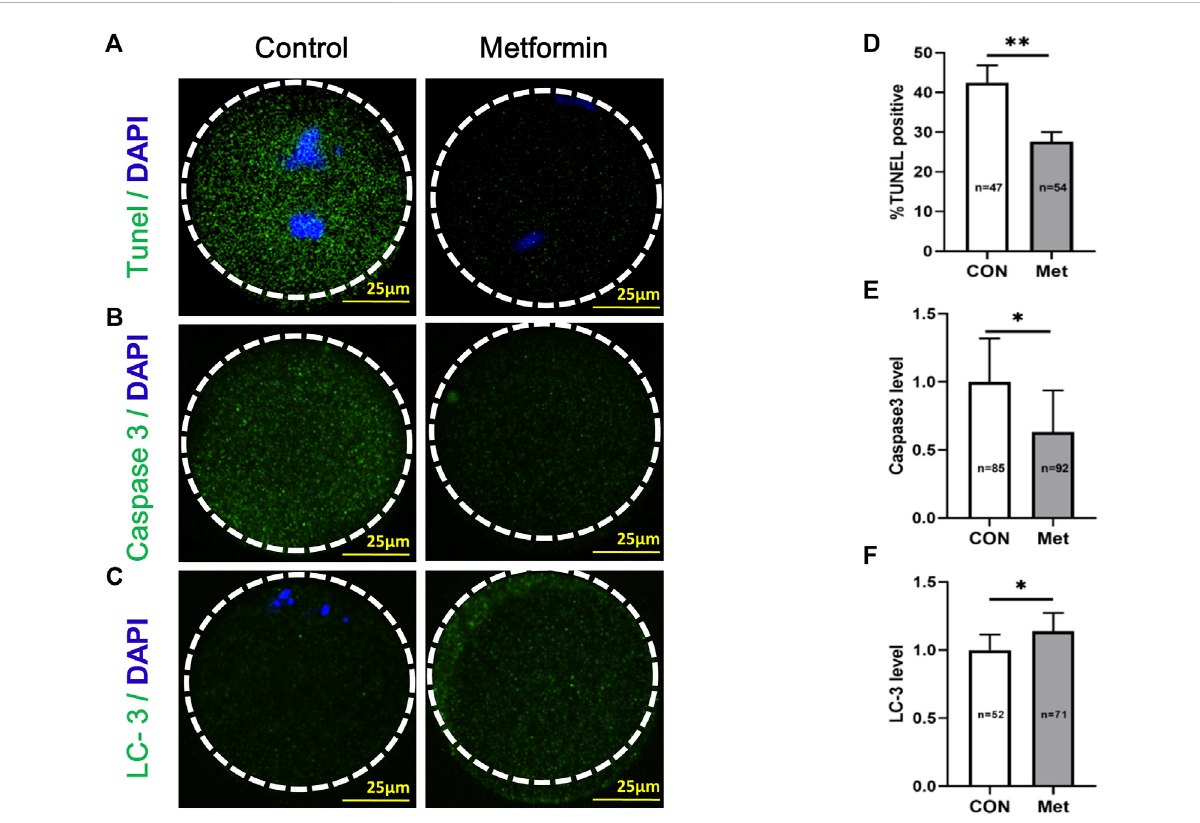
FIGURE 5 Metformin decreases apoptosis and increases anti-oxidative activity in oocytes from aged mice. (A) Representative apoptosis immuno fl uorescence images from TUNEL assays in M Ⅱ stage oocytes after IVM with or without metformin treatment. The green fl uorescence indicates TUNEL-positive oocytes; chromosomes were counterstained with DAPI (blue). Scale bar, 25 μ m. (B) Representative apoptosis immuno fl uorescence images of levels of activated Caspase 3 in M Ⅱ stage oocytes after IVM with or without metformin treatment. Scale bar, 25 μ m. (C) Representative immuno fl uorescence images of autophagosomes (LC3-II puncta) in M Ⅱ stage oocytes after IVM with or without metformin treatment. Scale bar, 25 μ m. (D) The percentage of TUNEL-positive oocytes in control ( n = 47) and metformin-treated oocytes ( n = 54). (E) Quanti fi cationofCaspase3intensityincontrol( n =85)andmetformin-treatedoocytes( n =92). (F) Quantitativeanalysisof fl uorescenceintensity showing the LC-3 level in control ( n = 52) and metformin-treated oocytes ( n = 71). Data are means ± SD of at least three independent experiments. Means±SD,* p < 0.05,** p < 0.01vs.controlascalculatedbytwo-tailedunpairedStudent ’ st-tests,the%dataaresubjectedtobytwo-tailedunpaired Student ’ s t-tests after an arcsine-square-root